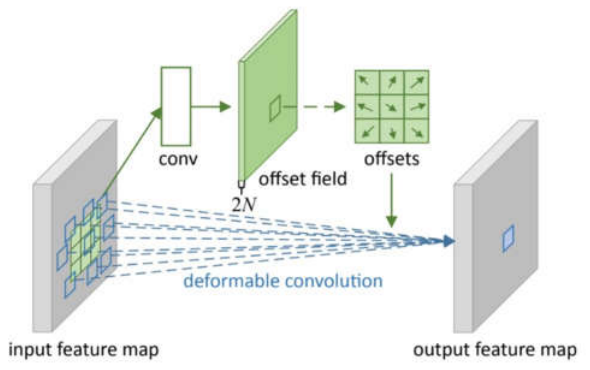
Figure 8. DCN Figure 8. DCN process.